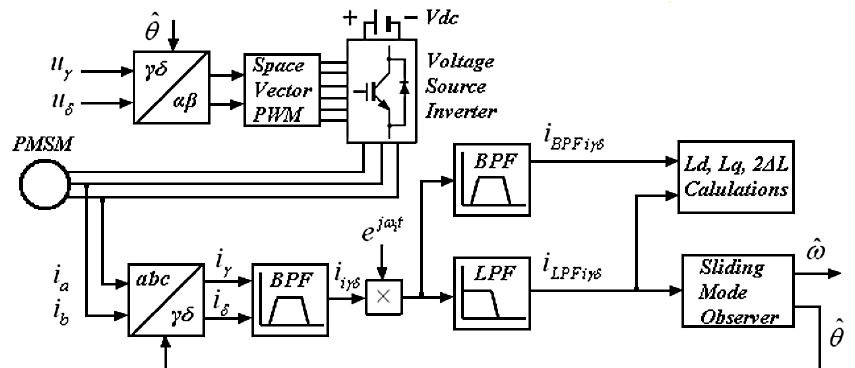
Figure 5. The observer and power supply blocks in more details as they used in simulation for PMSM sensorless control.